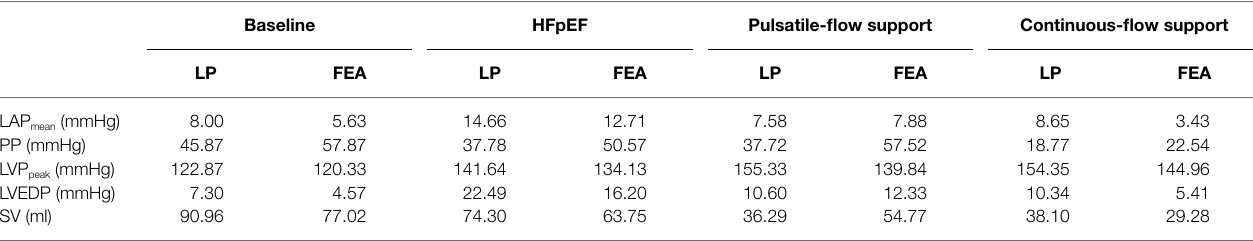
TABLE 1 | Comparison of hemodynamics at baseline, of the HFpEF phenotype, and of the HFpEF phenotypes with pulsatile or continuous support obtained by lumped-parameter (LP) and finite element analysis (FEA) modeling. Baseline HFpEF Pulsatile-flow support Continuous-flow